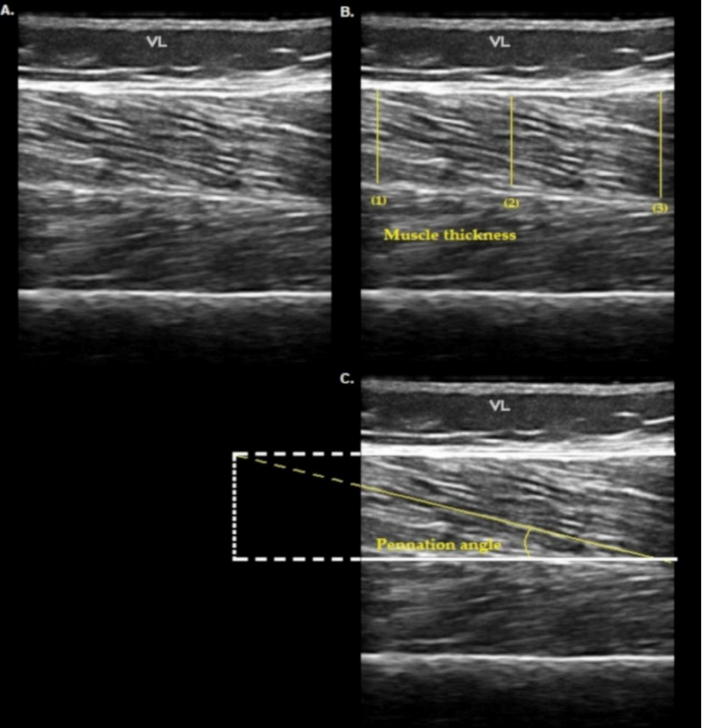
Figure 1. Ultrasound image showing vastus lateralis muscle architecture parameters. ( A ) Vastus lateralis image, ( B ) assessment of muscle thickness and ( C ) assessment of pennation angle. VL: vastus lateralis; (1): first parallel line drawn at right angles between the superficial and deep aponeurosis along ultrasonography image for muscle thickness; (2): second parallel line drawn at right angles between the superficial and deep aponeurosis along ultrasonography image for muscle thickness; (3): Third parallel line drawn at right angles between the superficial and deep aponeurosis along ultrasonography image for muscle